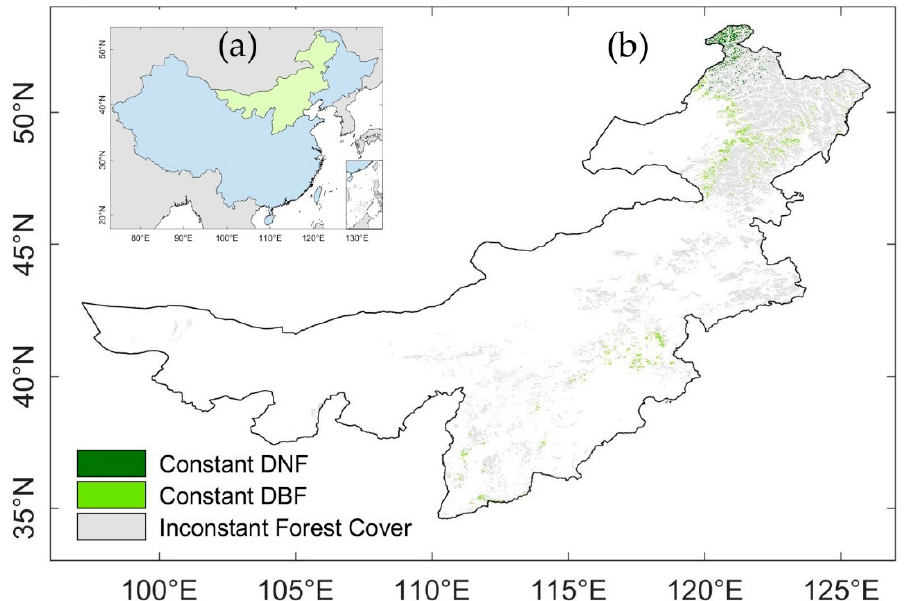
Figure 1. ( a ) The geographic location of the study area, North China, is filled with light green. The entire region of China is filled with light blue. All the colored areas are land. ( b ) Spatial distribution of forests in North China. The emerald pixels are deciduous needleleaf forests (DNFs) which were constant during 2001–2018. The grass-green pixels are deciduous broadleaf forests (DBFs) constant during 2001–2018. The gray-colored pixels are forests where the type was inconstant between the China Vegetation Map and MCD12Q1 or altered during 2001–2018 in the MCD12Q1 dataset.